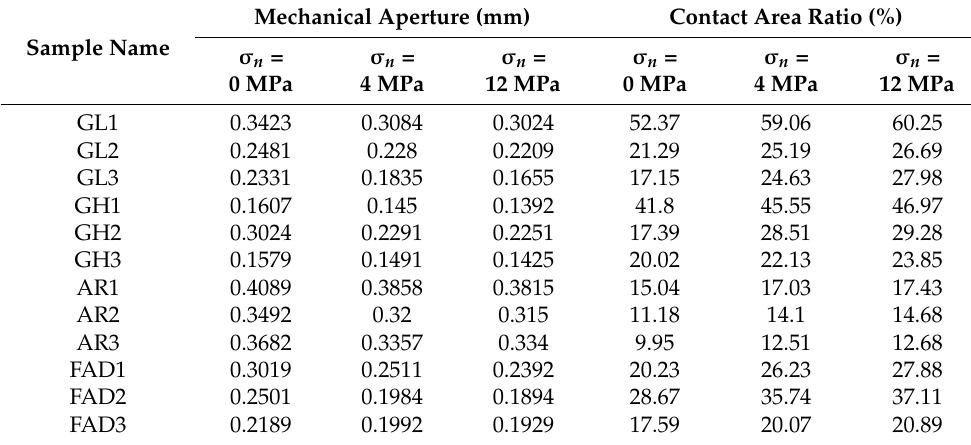
Figure 12. Variation of the mechanical aperture and contact area ratio under various normal stress conditions for the GL1 specimen. Table 5. Mechanical apertures and contact area ratios under various normal stresses for natural fracture specimens.